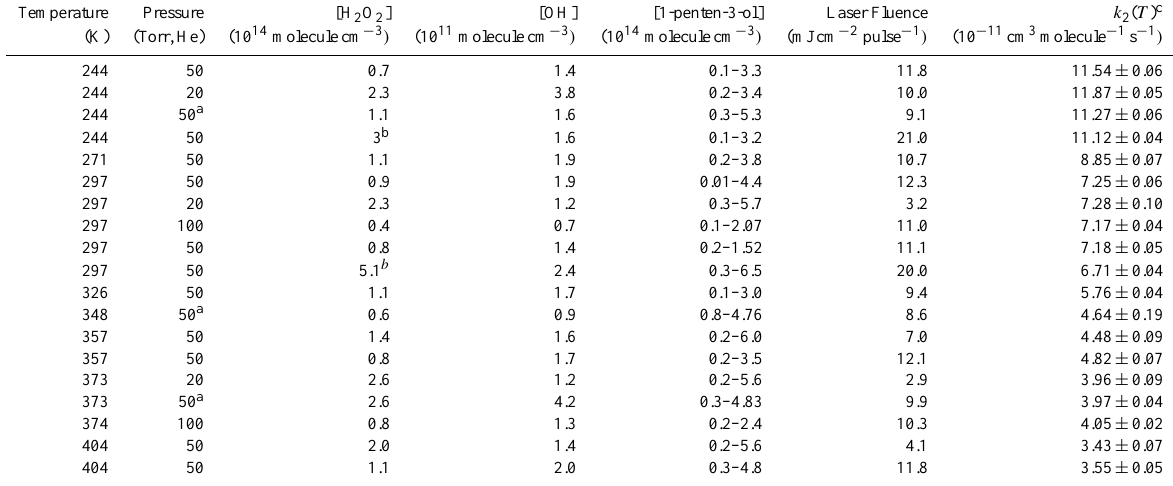
Table 3. Summary of experimental conditions and measured rate coefficients, k 2 ( T ), for the OH+1-penten-3-ol reaction. Temperature